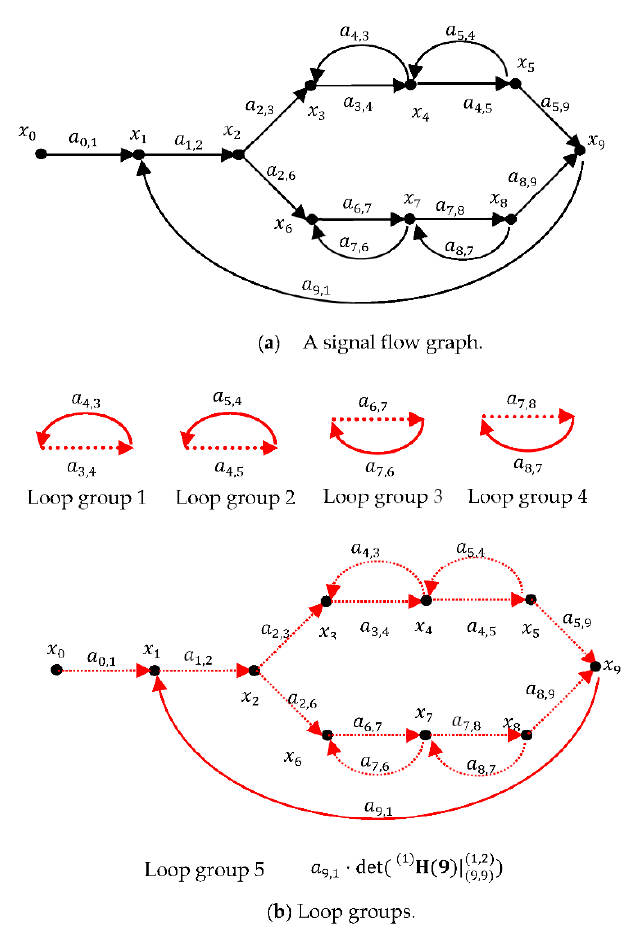
Figure 4. A signal flow graph for example 2.